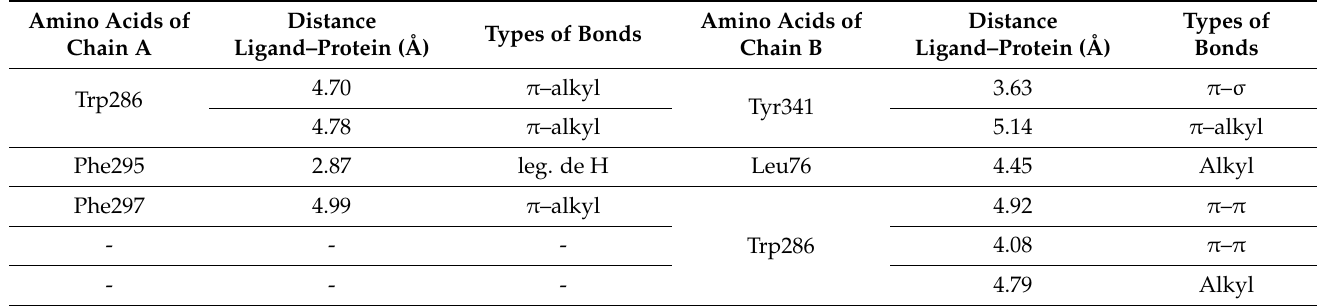
Table 3. Galantamine–AChE ligand–receptor interactions at the A and B